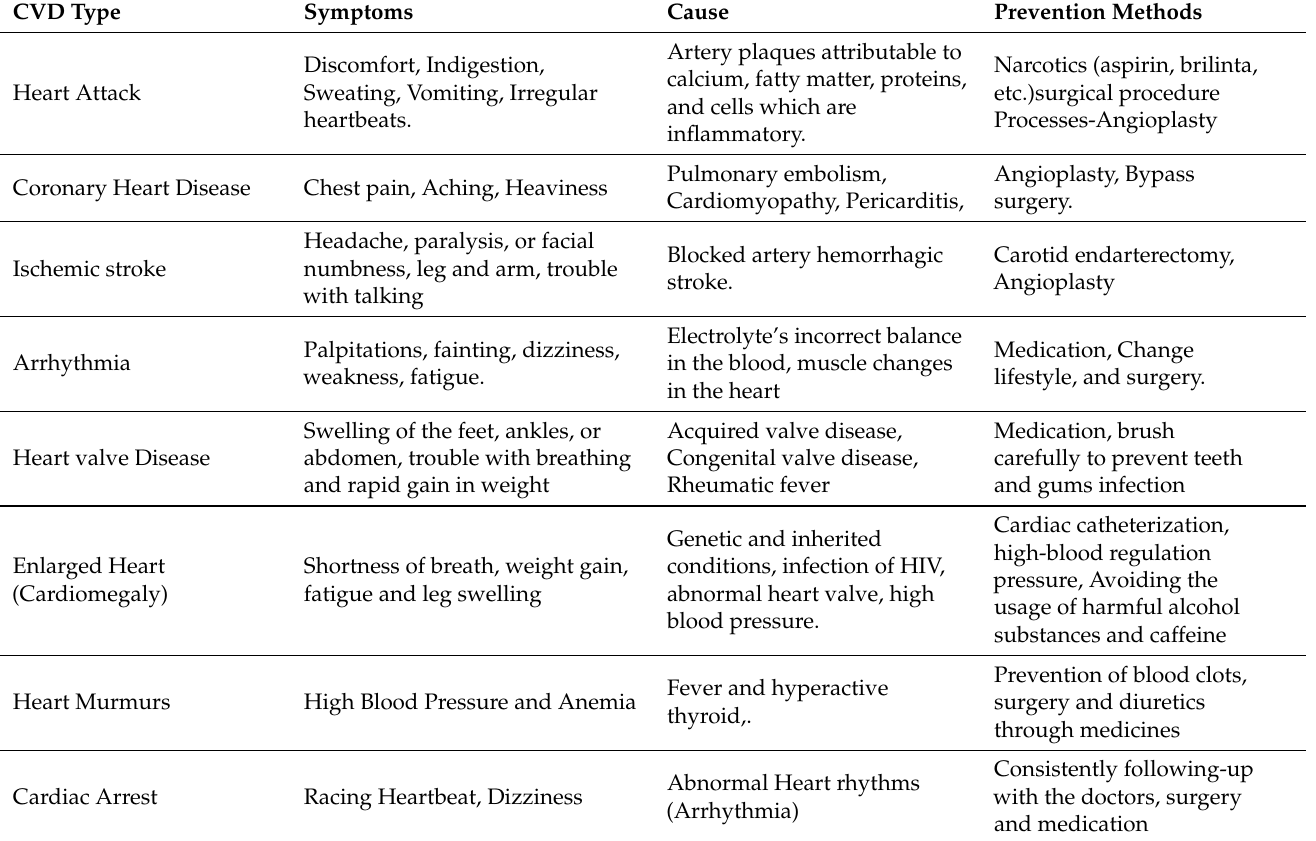
Table 1. Different types of cardiovascular diseases based on